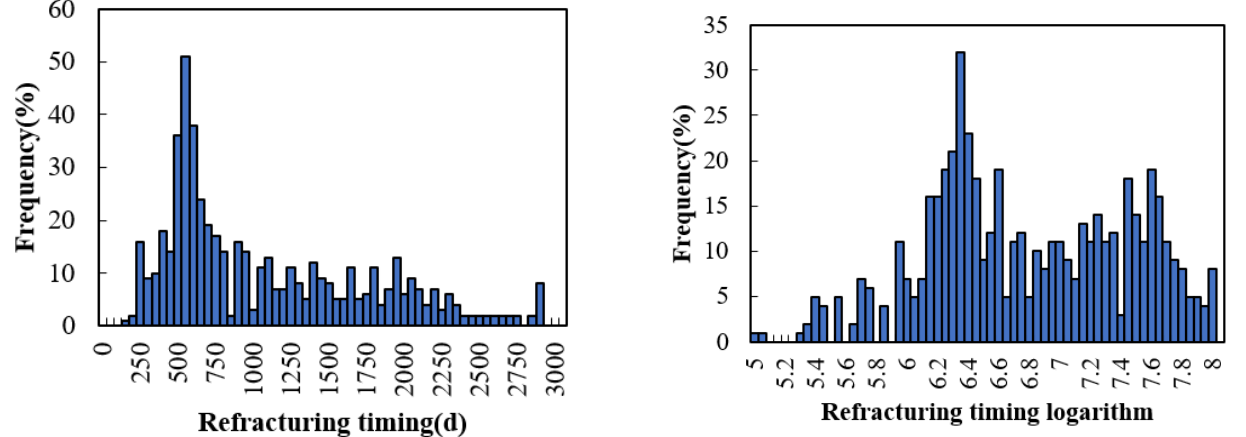
Figure 3. Comparison of Distribution before and after logarithmic transformation of refracturing timing.